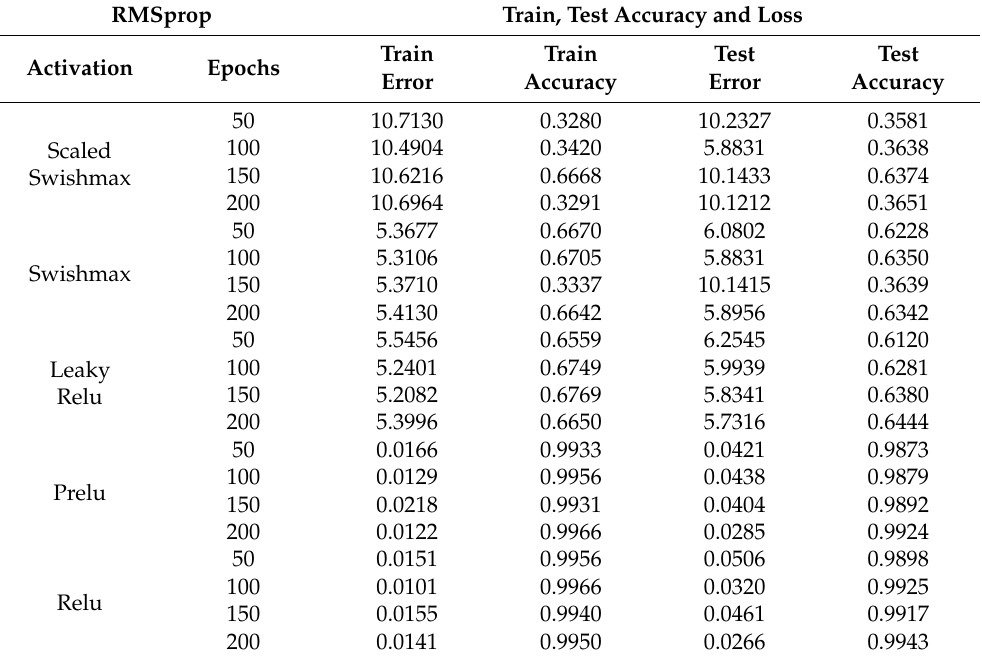
Figure 7. Model’s training and test loss over epochs with RMSprop and ReLU. Table 2. The comparisons of the training error and accuracy and test error and accuracy in relation with varying epoch sizes.